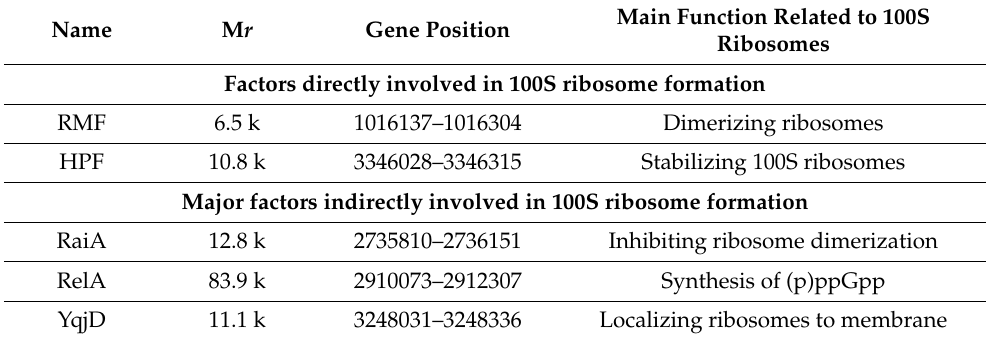
Table 1. Factors related to ribosome hibernation in Escherichia coli